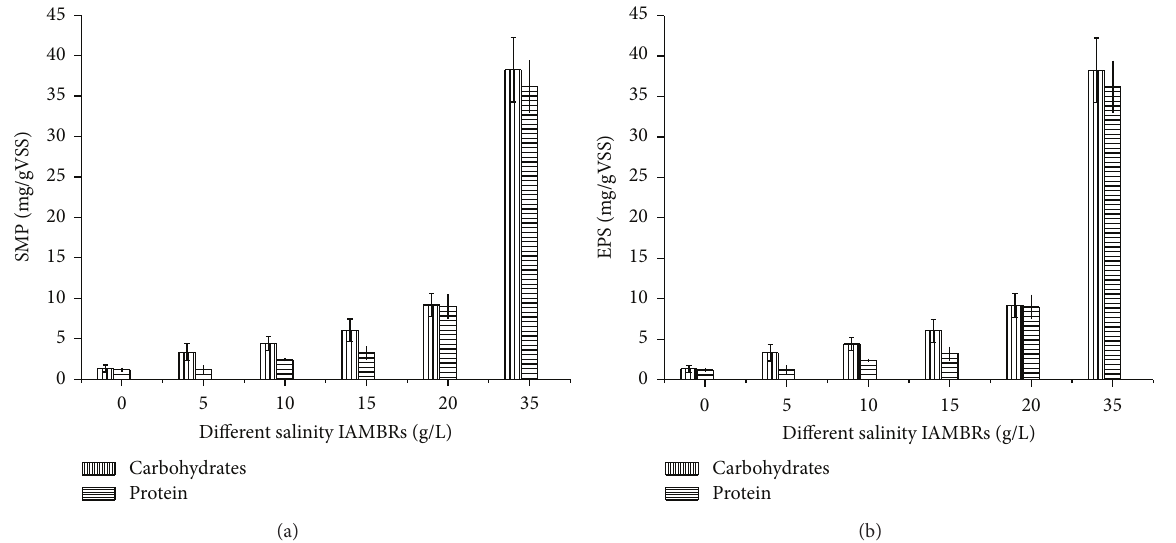
Figure 4: The variation of SMP (a) and EPS (b) at different salinity. The error bars show the standard deviation of the total concentrations in both (a) and